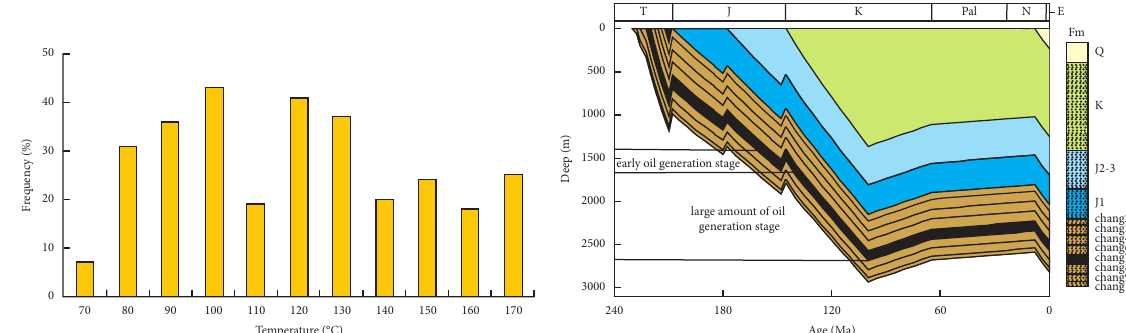
Figure 10: The homogenization temperature and burial history of inclusions in the study area (revised according to reference [38]).